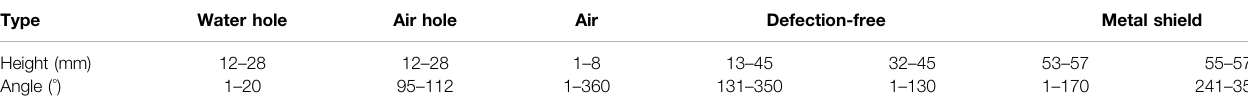
TABLE 2 | Range of training set.